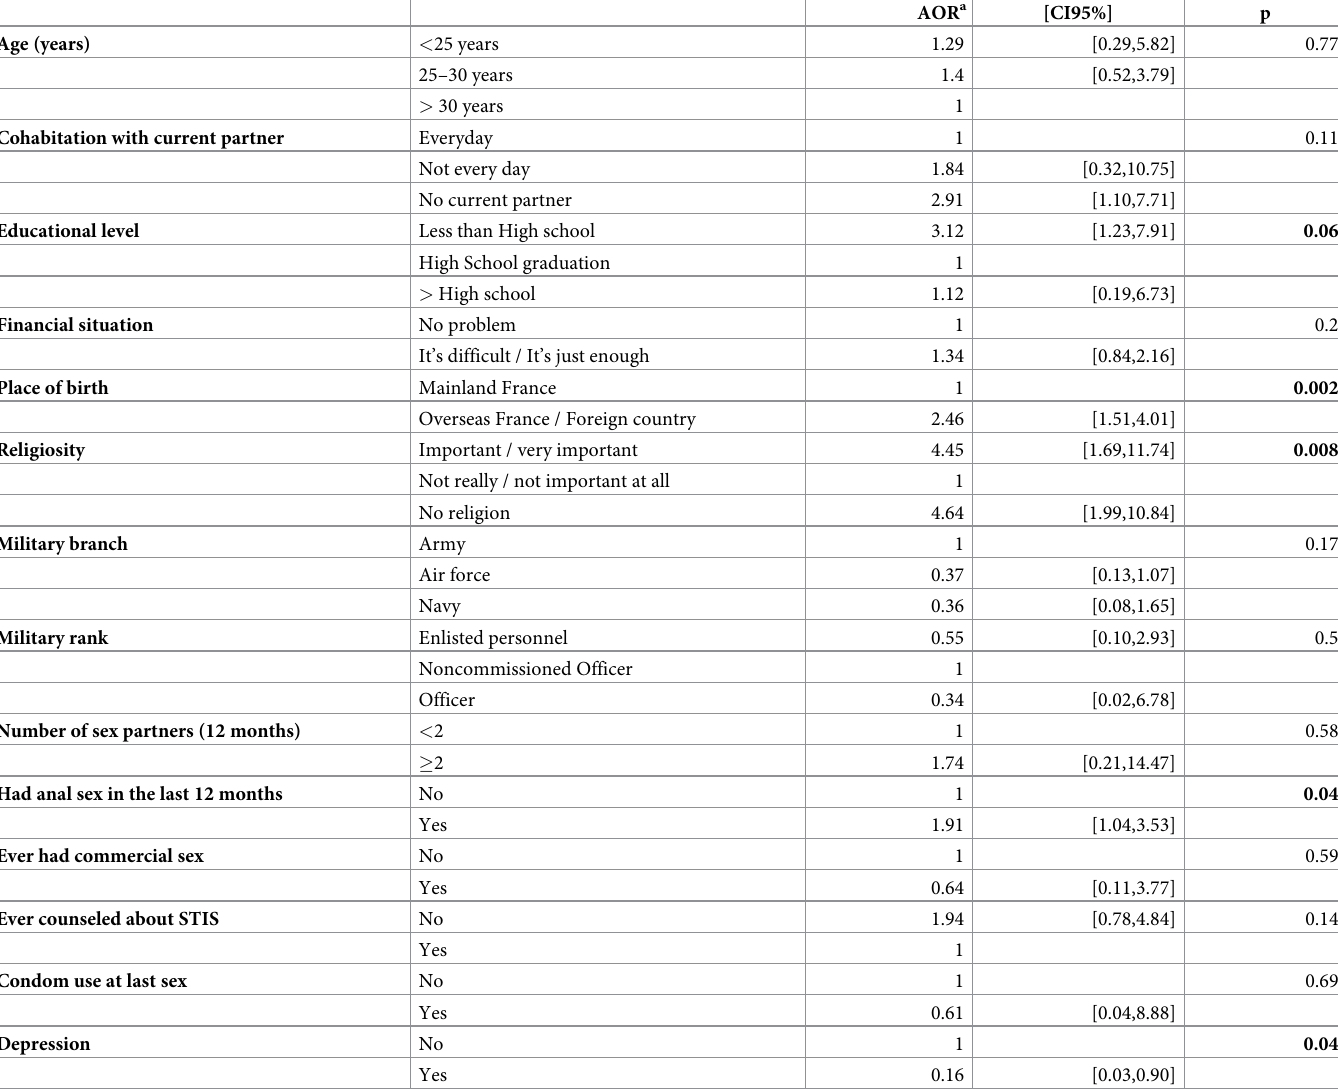
Table 5. Factors associated with biologically confirmed STIs (diagnosed STIs)- results of multivariate logistic regression (n = 753), COSEMIL